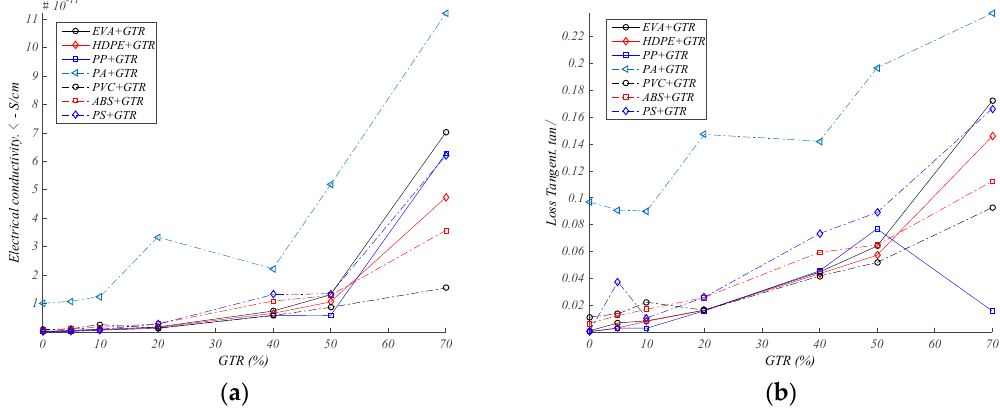
Figure 8. ( a ) Electrical conductivity (S/cm), ( b ) Loss Tangent (Tan δ ) for different polymers/GTR concentrations and particle size <200 μ m, and frequency fixed at 50 Hz and 30°.